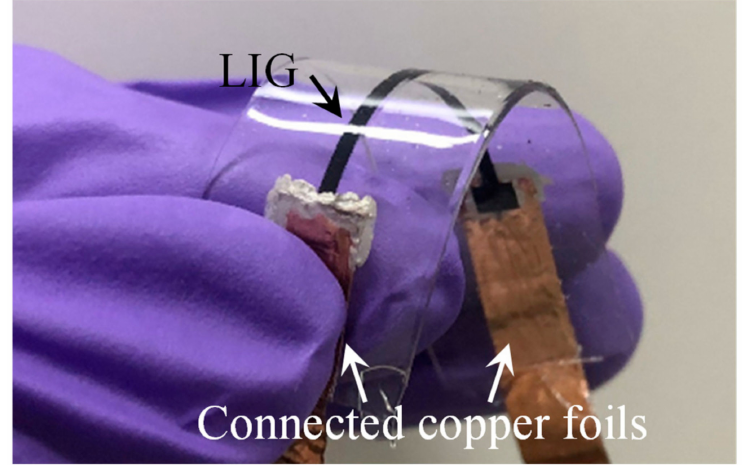
Figure 7. Fabricated LIG stain sensor.